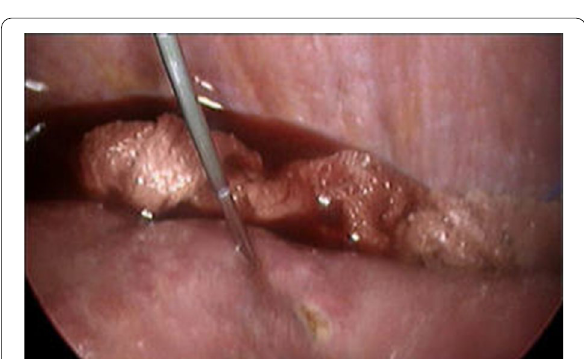
Fig. 4 LARFA of subdiaphragmatic HCC with